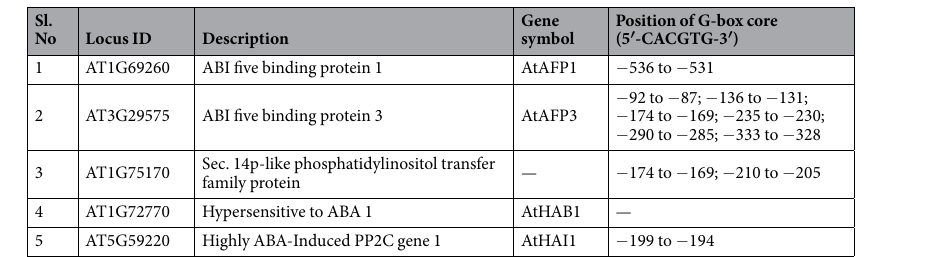
Table 1. Potential targets of AtGBF3 with predicted G-box core motif on their